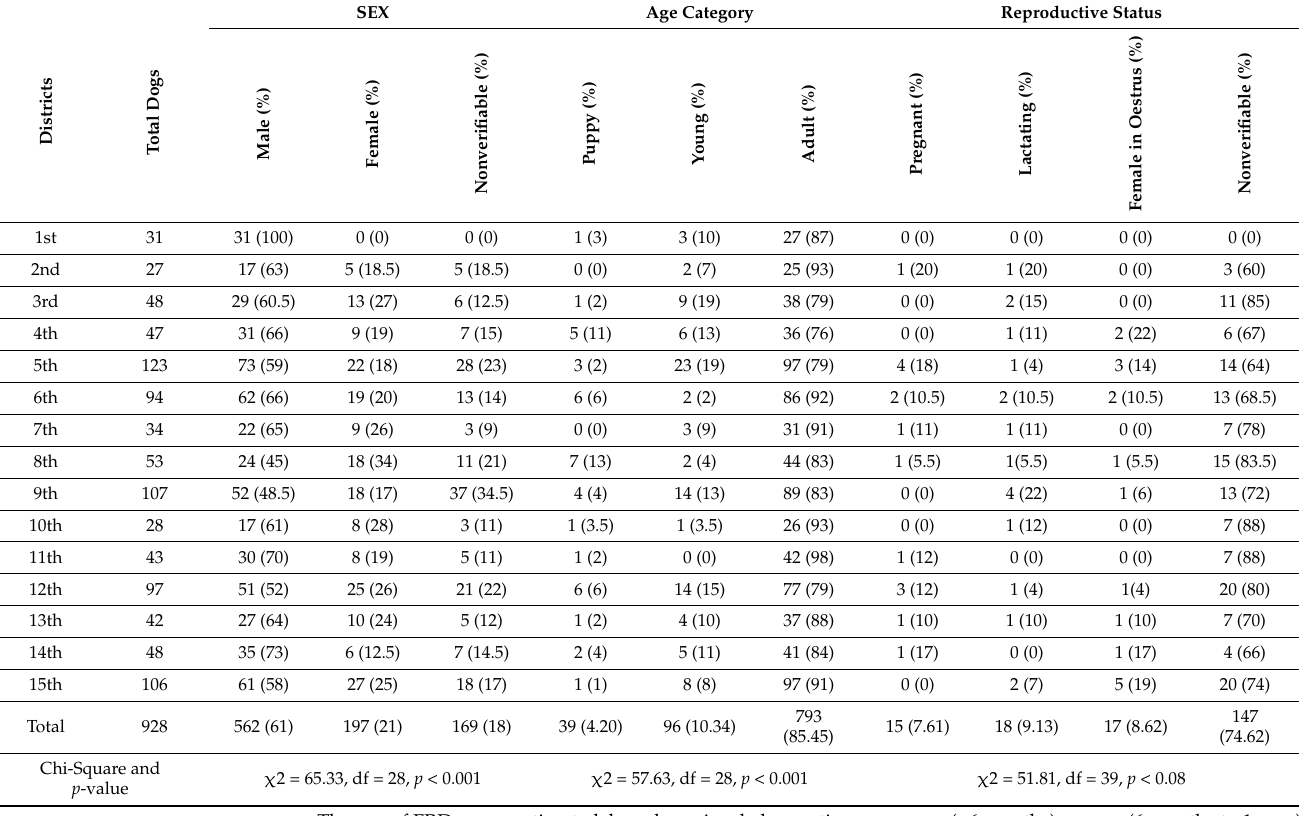
Table 1. Demographic details (sex, age distribution and reproductive status) of FRDs observed in 15 districts of Herat